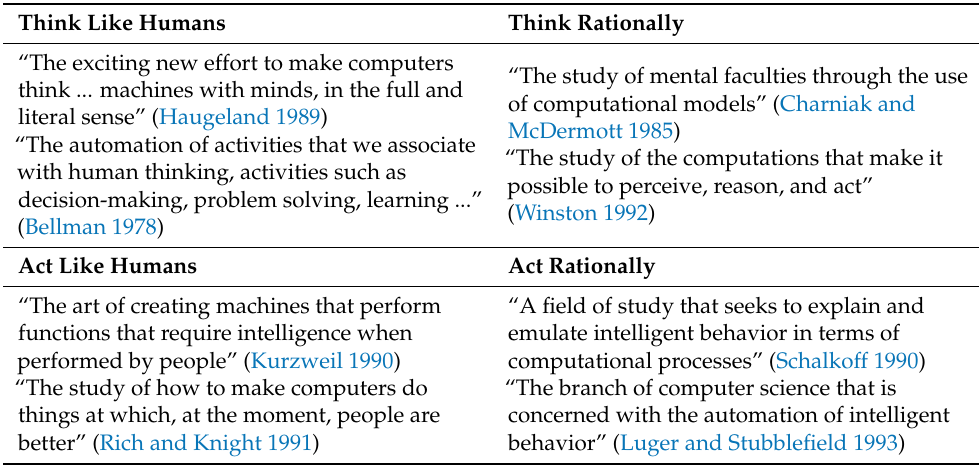
Table 1. Definitions of artificial intelligence based on their approach. Adopted from Deshpande (2009). Think Like Humans Think